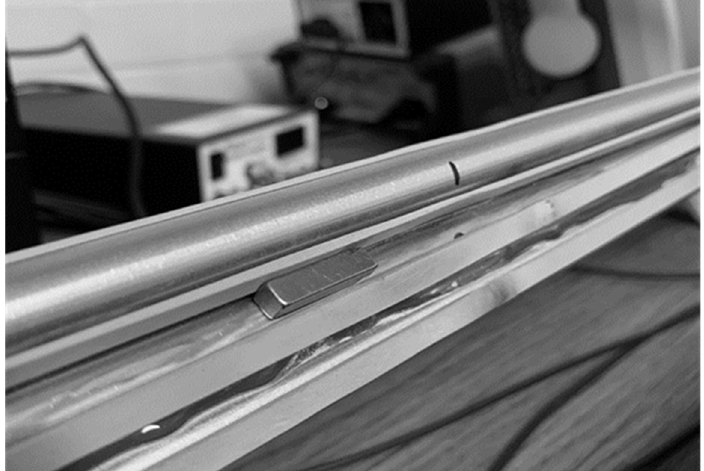
Figure 4. Image of defected array of three coupled aluminum rod waveguides. The image shows the rubber bands flanking the rods. The magnet scatterers are binding to the groove made by the top two rods. In the image only one side of the array of waveguides and one magnet are visible.